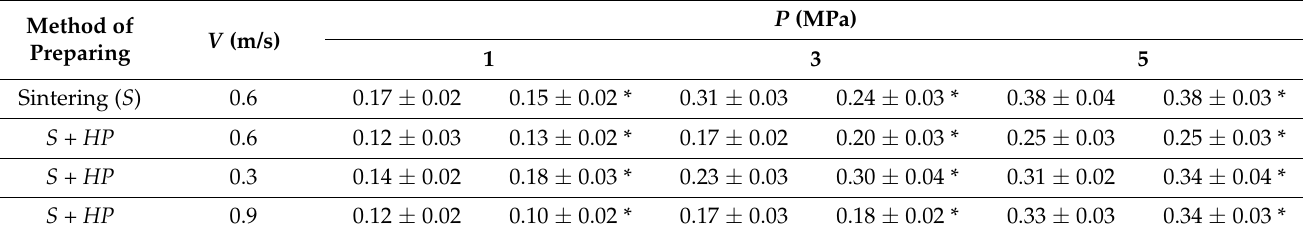
Table 3. Effect of the HP processing and parameter P · V on the linear wear intensity Ih ( µ m/m) of